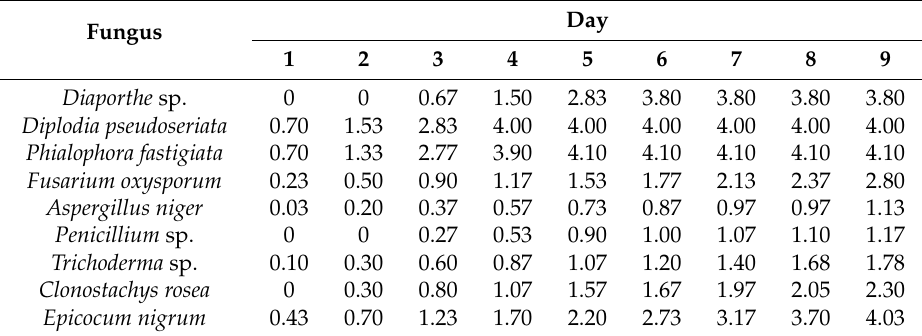
Table 3. Growth of the control fungi (in cm) over the nine days of the tests (mean values from three